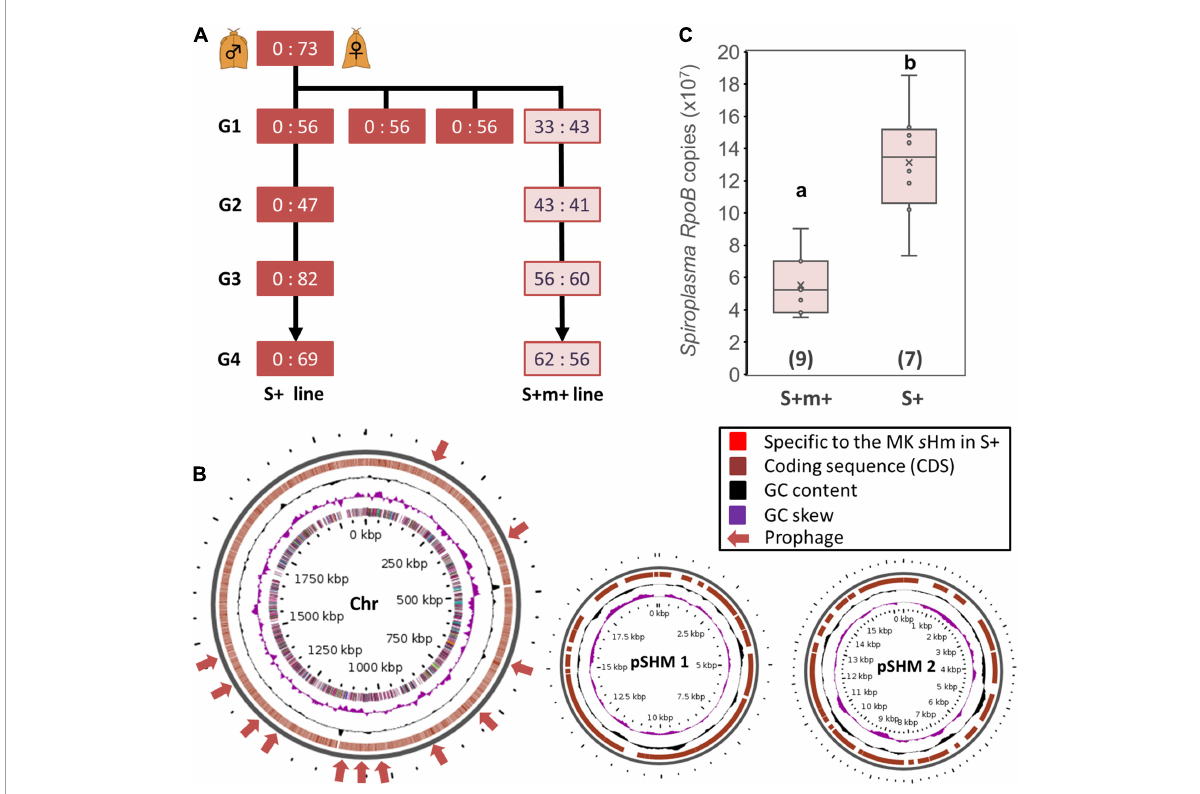
FIGURE4 Comparison of Spiroplasma strain s Hm in MK and non-MK Homona magnanima lines. (A) Spiroplasma -positive 1:1 sex ratio line (S+M+ line) was maintained for over four generations (G1–G4), parallelly with the all-female S+ line. (B) Structural variations of the genome of Spiroplasma strain s Hm in the MK (S+) and non-MK (S+M+) H. magnanima lines were visualized via Gview software. No obvious structural variations (i.e., the red colored loci), specific to MK s Hm strain in the S+ matriline, were identified. Chr: main chromosome (2.1 Mb); pSHM 1: sHm plasmid 1 (20 Kb); pSHM 2: sHm plasmid 2 (16 Kb). (C) Abundance of Spiroplasma (based on copy numbers of RpoB ) in adult females (0-day post eclosion) of S+M+ line and S+ line. The horizontal bar within the box represents the median. The upper and lower hinges of the box indicate upper quartile and lower quartile, respectively. Sample sizes (numbers of examined individuals) are indicated in parentheses. Different letters indicate significant differences between groups (Steel–Dwass test, P <